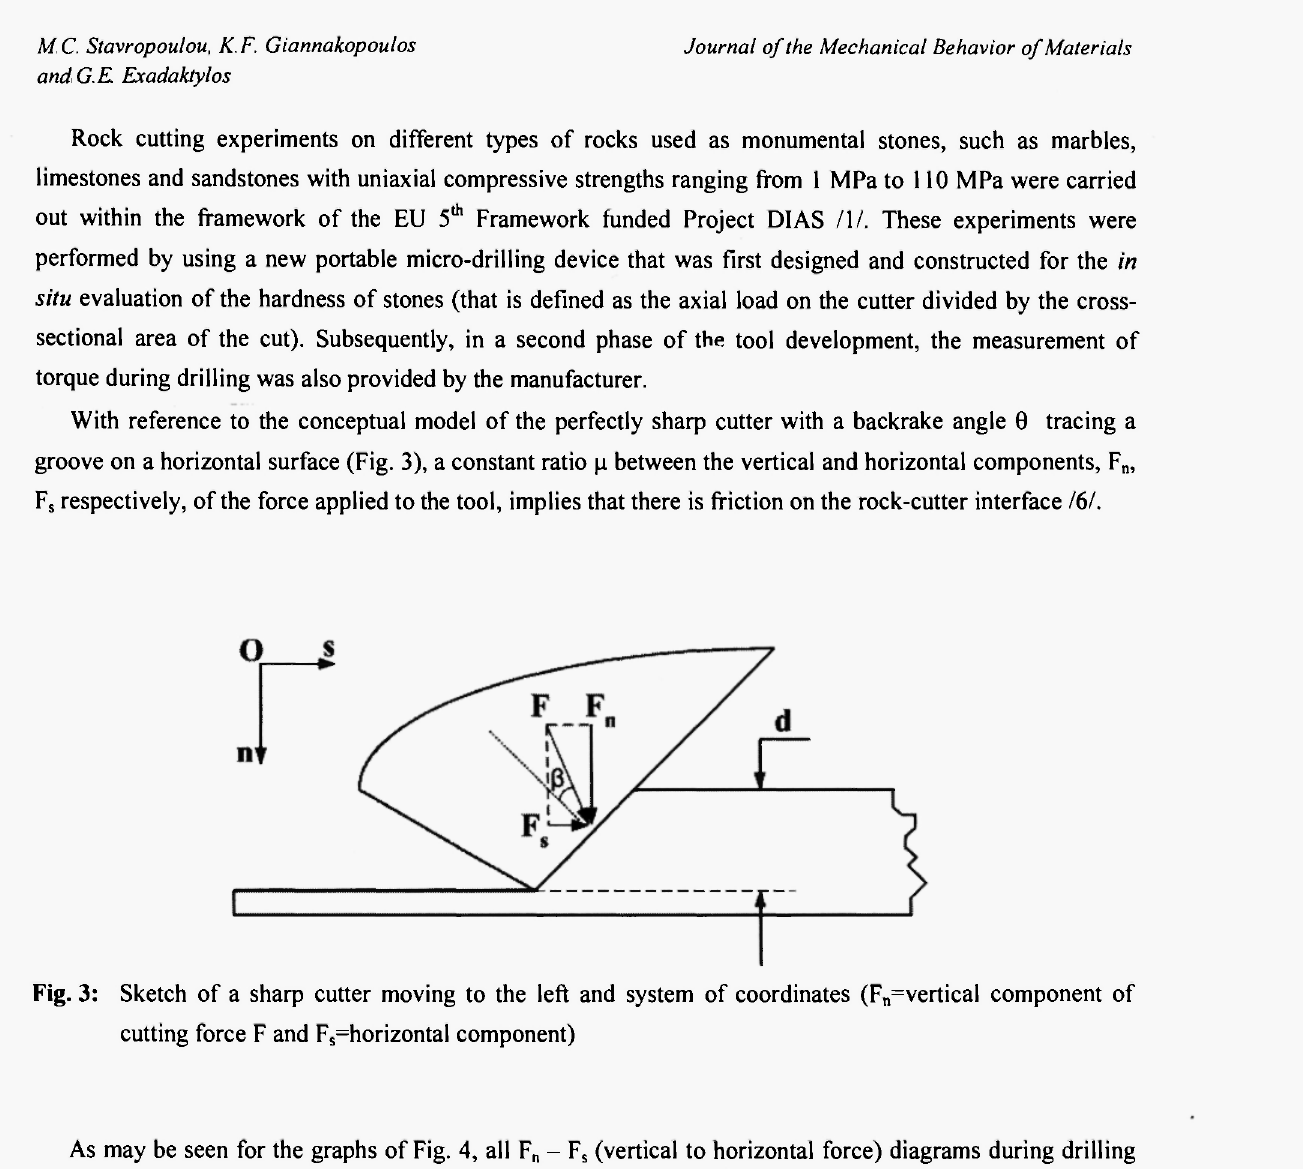
Fig. 3: Sketch of a sharp cutter moving to the left and system of coordinates (F n =vertical component of cutting force F and F s =horizontal